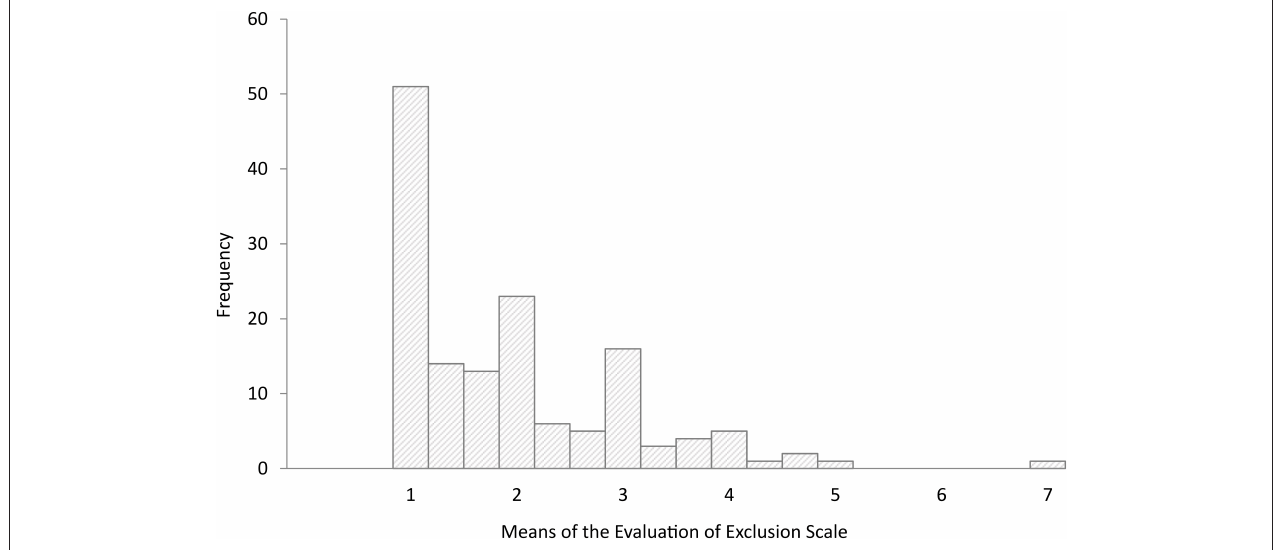
FIGURE 1 | Distribution of the means of the evaluation scale. Note: The scale was created by combining the three evaluation items (not okay/okay, unfair/fair, unjustifiable/justifiable) indicating a participant’s evaluation of the exclusion. High numbers indicate high acceptability of exclusion; low numbers indicate strong rejection of exclusion.